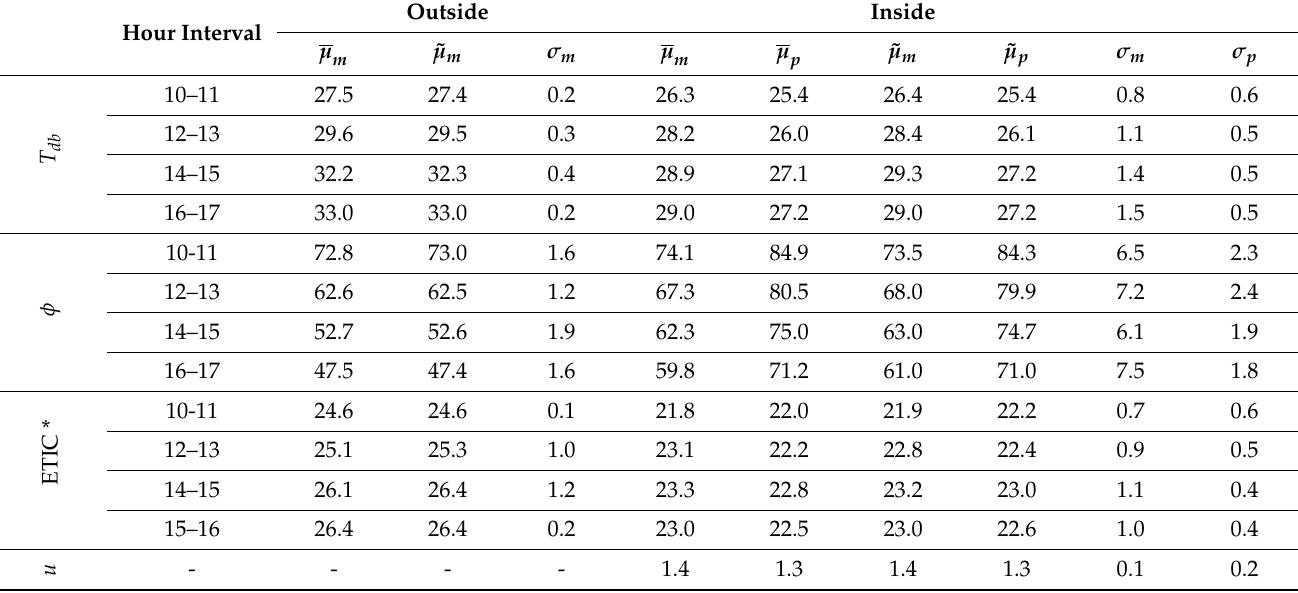
Table 4. Statistics of psychometric properties of the air measured ( m ) outside and inside the tunnel- ventilated compost bedded dairy barn used to validate the proposed CFD model and the predictions made with it ( p ). T db is the dry-bulb temperature ([ ◦ C]), φ is the relative humidity ([%]), ETIC is the Equivalent Temperature Index for dairy Cattle ([ ◦ C]), u is the air velocity ([m s − 1 ]), µ is the mean, ˜ µ is the median and σ is the standard deviation.